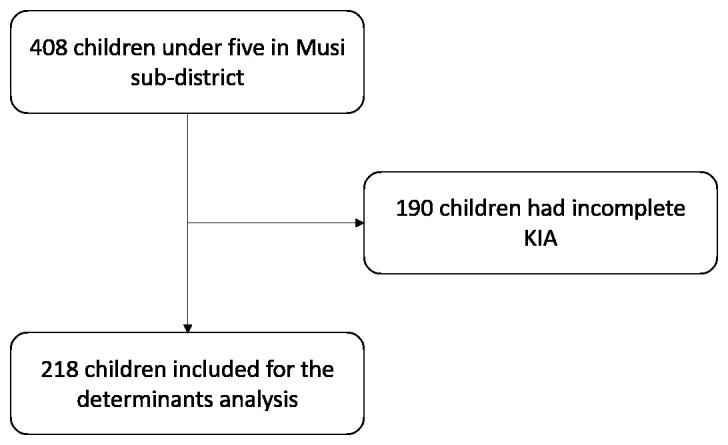
Flow chart of the study population selection for determinants analysis.